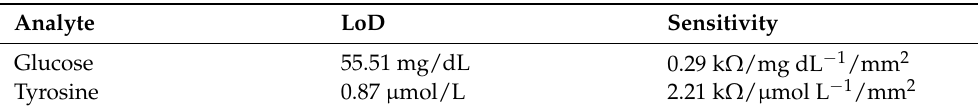
Table 2. Comparison of LoD and sensitivity towards glucose and tyrosine detection using Arduino UNO based portable device.